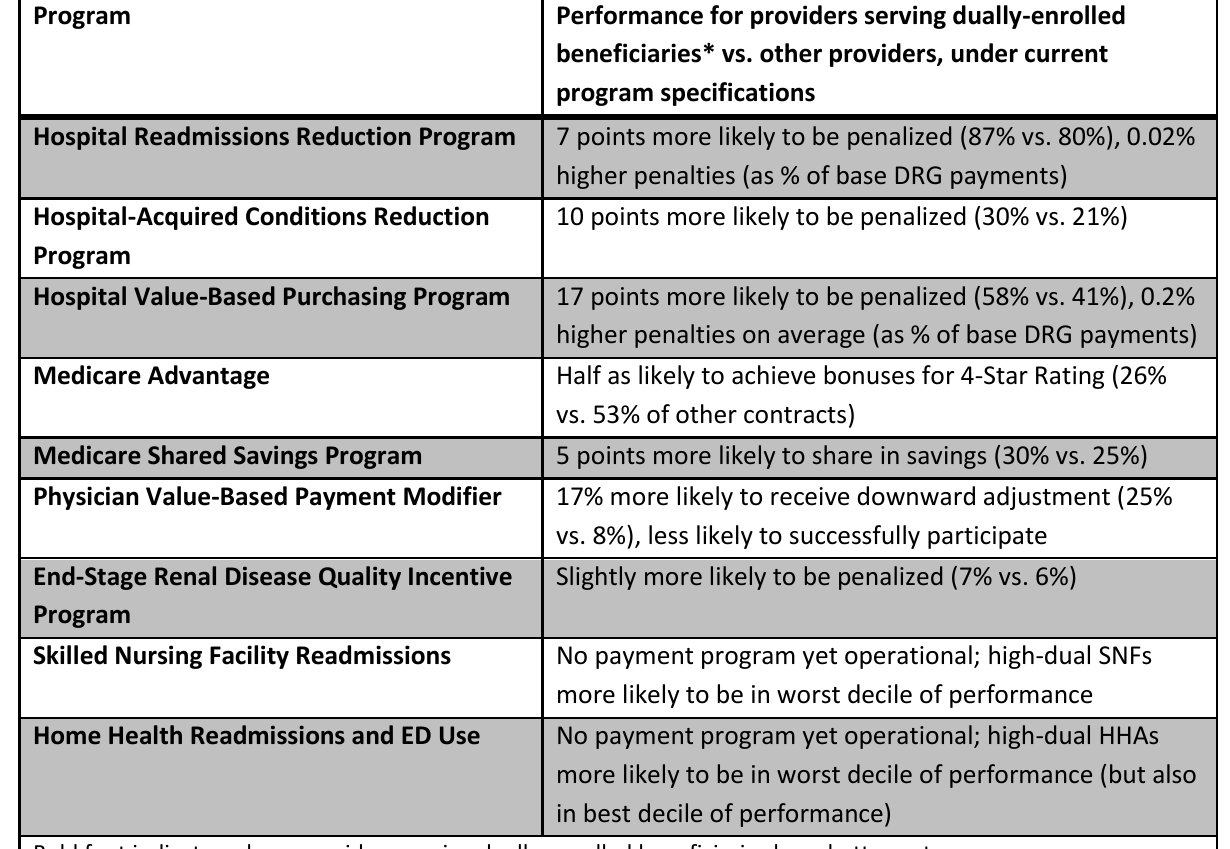
Table 14.3: Relationship Between Providers and Plans Disproportionately Serving Dually-Enrolled Beneficiaries and Penalties Across Programs